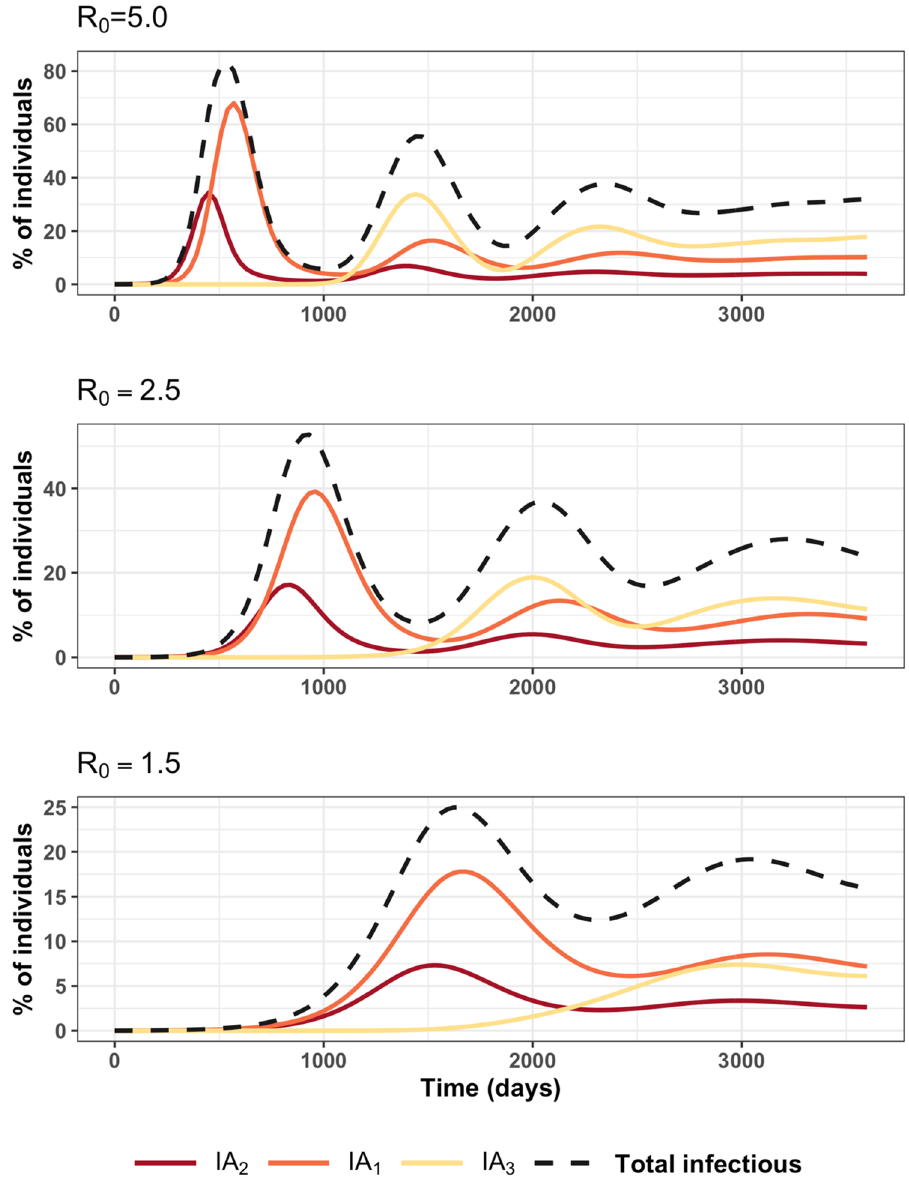
Figure 2. Average proportion of infected animals of type “ i ” ( IA 2 : carrying IgM and IgG antibodies, IA 1 : only carrying IgG and IA 3 carrying high-level of IgG) as a function of time for various values of R 0 . Proportion = 100 × number of animals / total population; with total population =